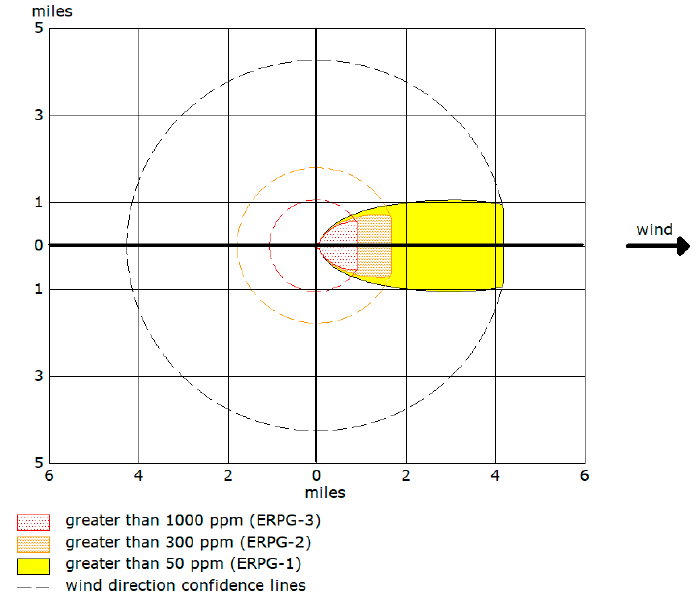
Figure 4. Example of identified ERPG threat zones in ALOHA.